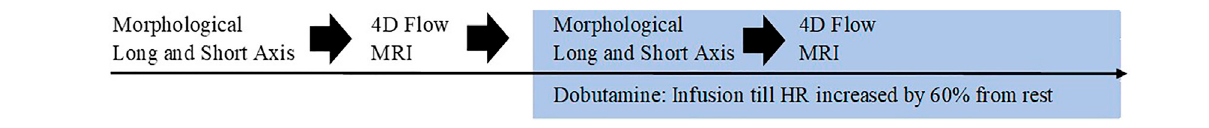
FIGURE 1 | MRI protocol. Morphological images and 4D fl ow data collected at rest and with dobutamine infusion; HR, Heart Rate.